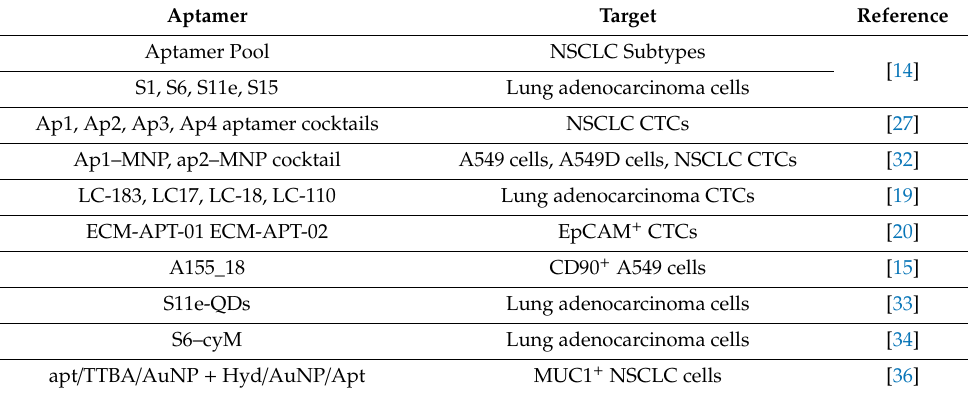
Table 2. Examples of aptamers used for NSCLC